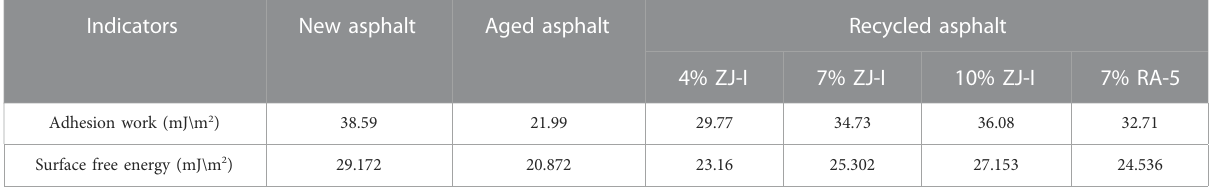
TABLE 16 Adhesion work and surface free energy.